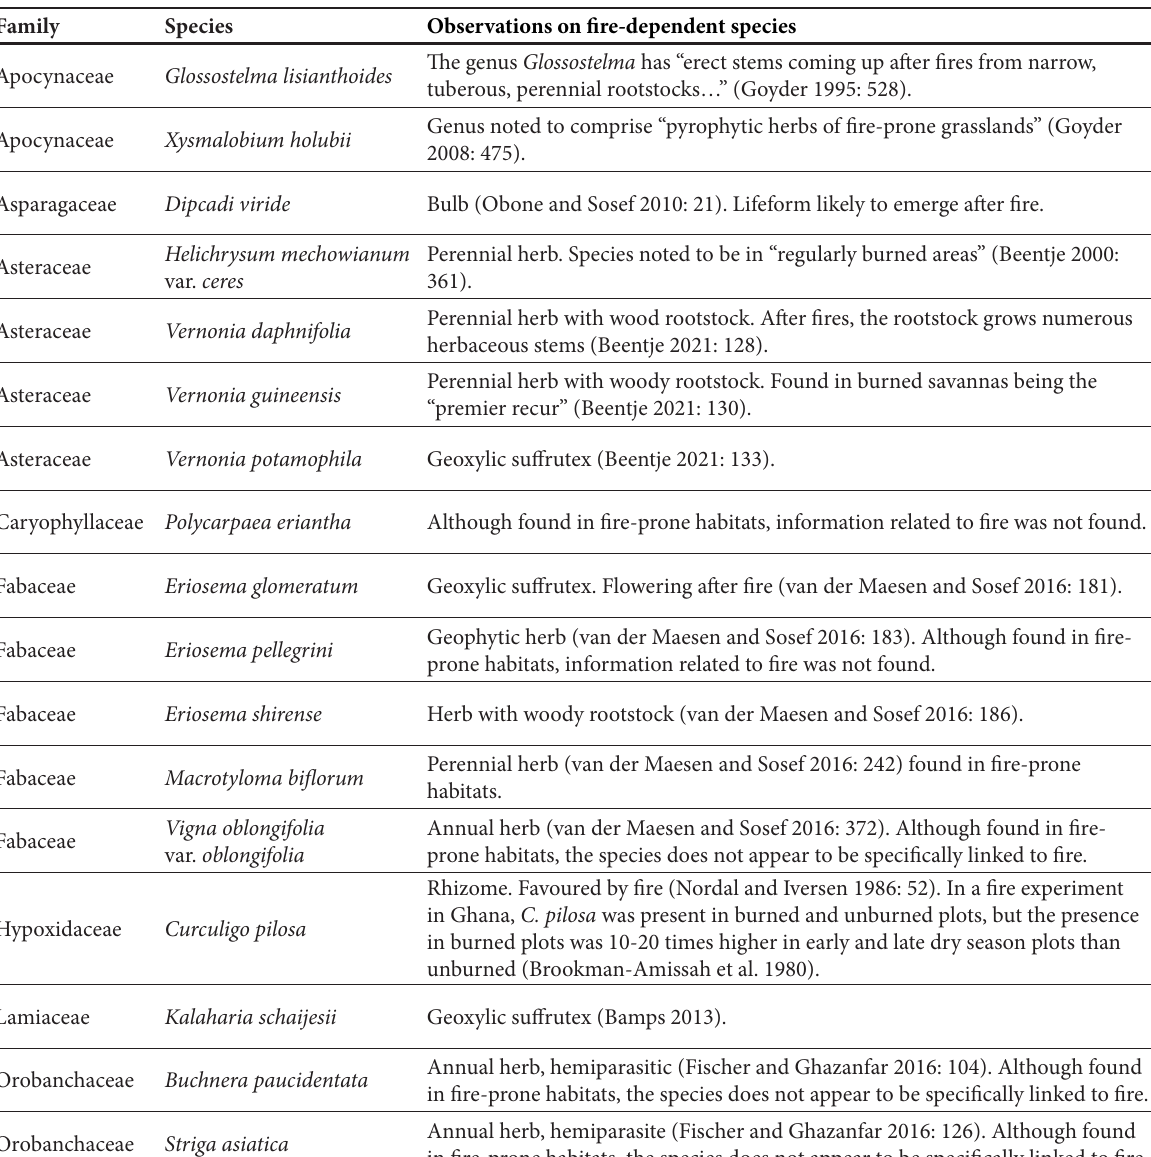
Table 6. Species unique to burned plots, with observations on fire-related aspects of species